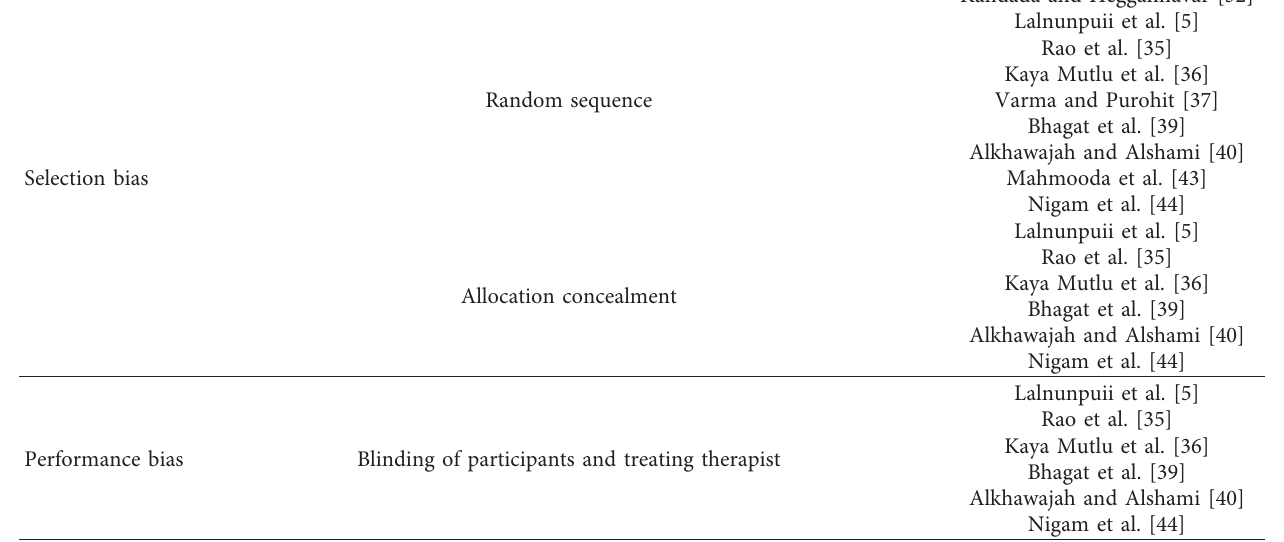
Table 3: Risk-of-bias